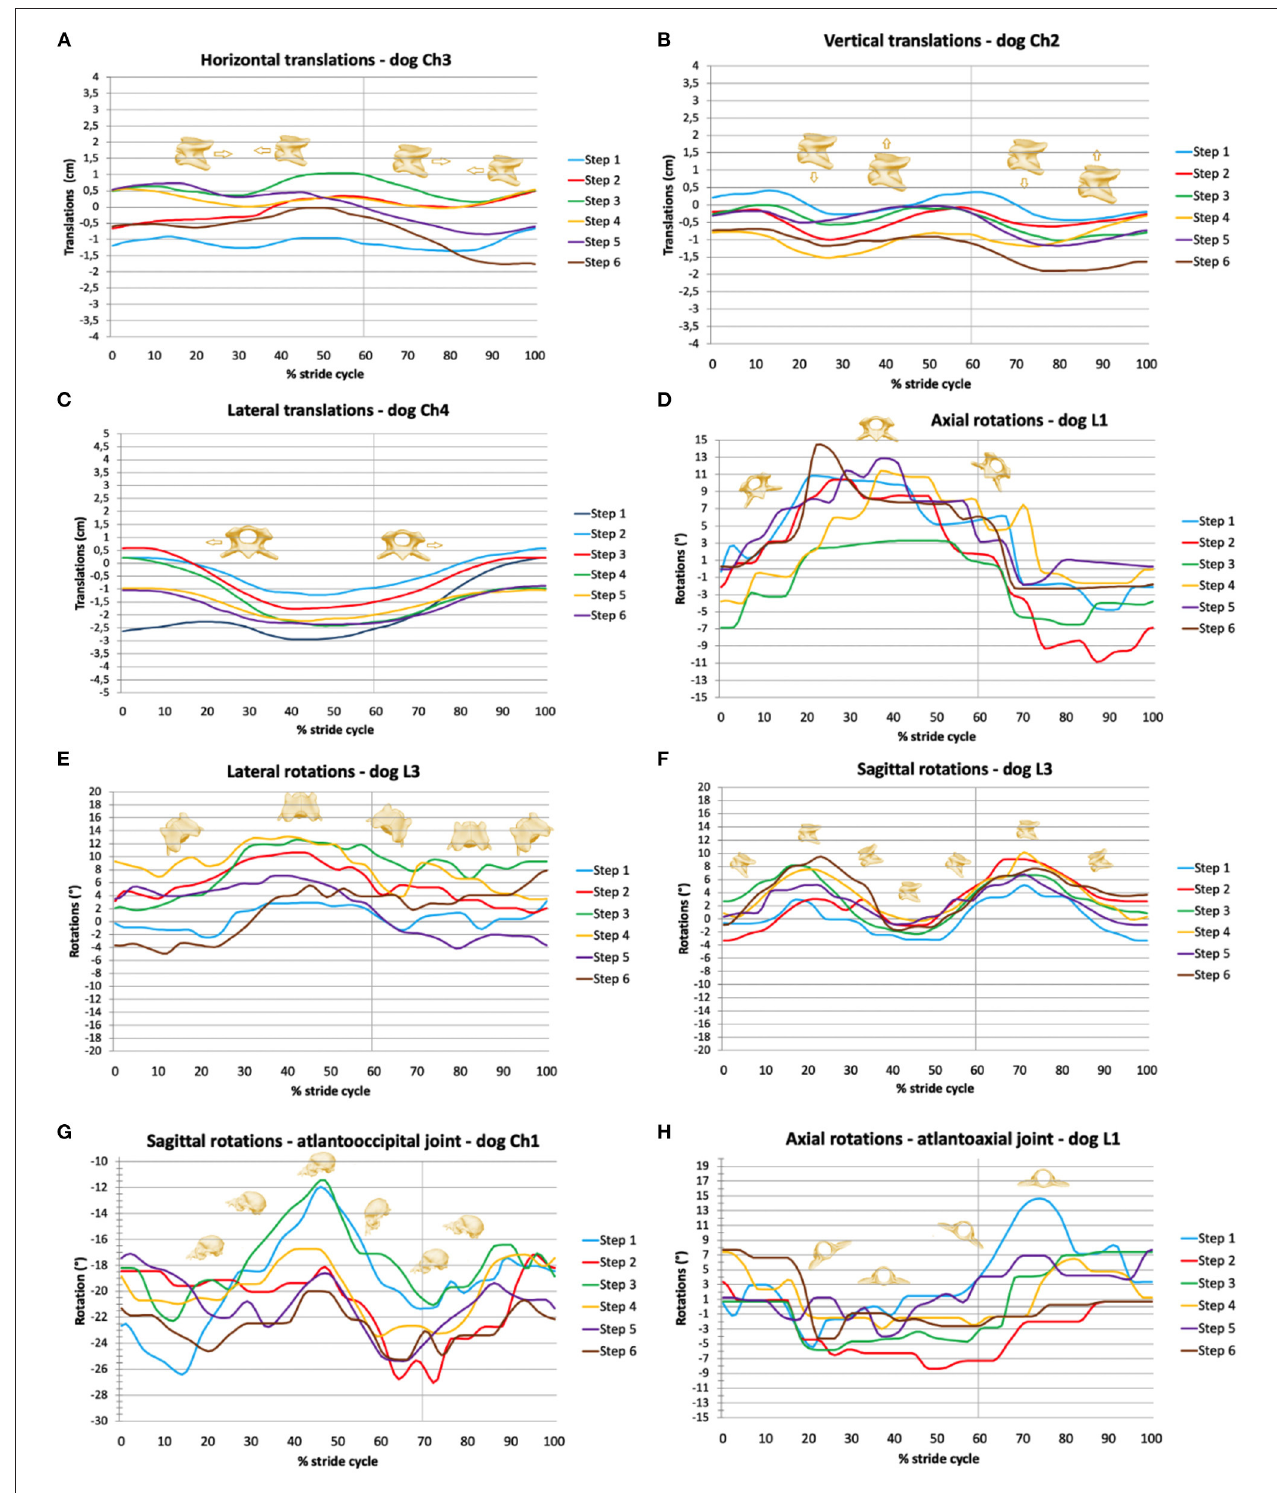
FIGURE 3 | Stride-phase-normalized gait-cycle-dependent movements of the total upper cervical motion (TUCM), atlantoaxial joint, and atlantooccipital joint. Six walking stride cycles (step 1 to step 6) for each dog are presented. X-axes represent the stride cycle from touch-down (0%) to subsequent touch-down of the reference limb (100%). The vertical line indicates the duty factor. (A) Horizontal, (B) vertical, and (C) lateral translations of the TUCM. (D) Axial, (E) lateral, and (F) sagittal rotations of the TUCM. (G) Axial rotations of the atlantoaxial joint, (H) sagittal rotations of the atlantooccipital joint.